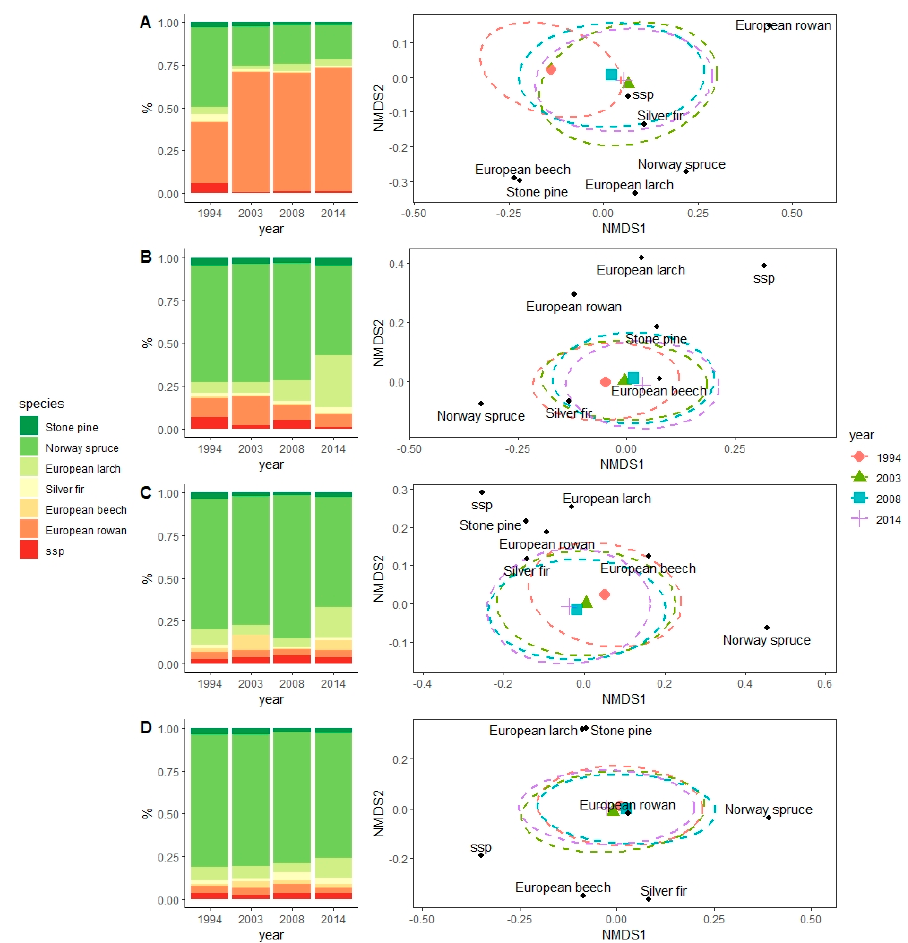
Figure 3. Barplots of species composition and Non-Metric Multidimensional Scaling (nMDS) plots with 95% confidence interval ellipses for each year, within each size class (from top to bottom A, B, C and D ).